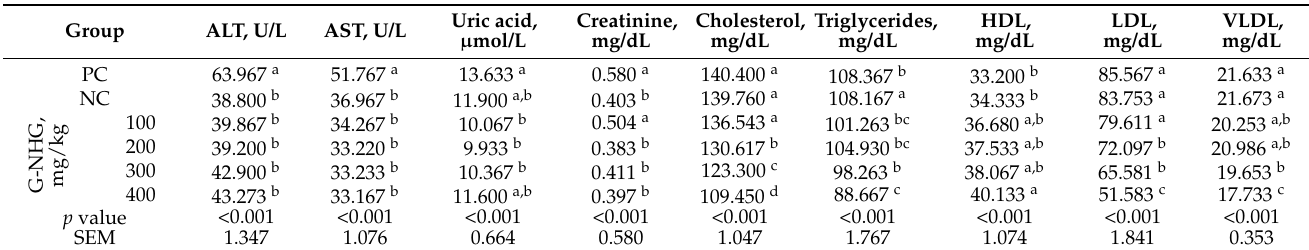
Table 5. Effect of varying dietary G-NHG levels on broiler chicken’s serum biochemical parameters at 38th day of age post challenge with C. perfringens